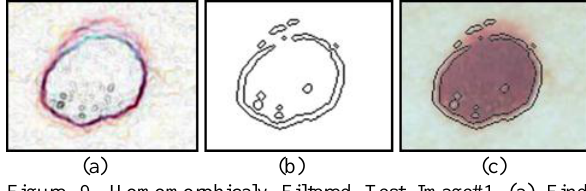
Figure 9. Homomorphicaly Filtered Test Image#1 (a) Find Edges (b) Photocopy filter (Det: 5, dark:5) (c) overlay with original